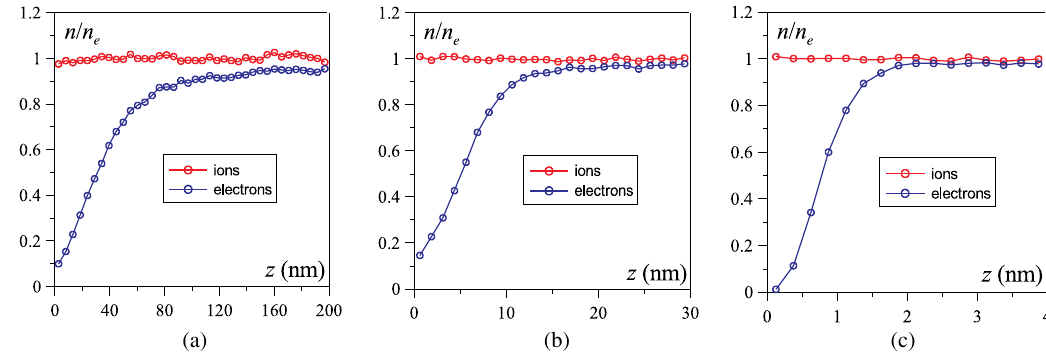
FIG. 6. Density profiles for electrons and ions at the final stationary state depending on the mean electron number